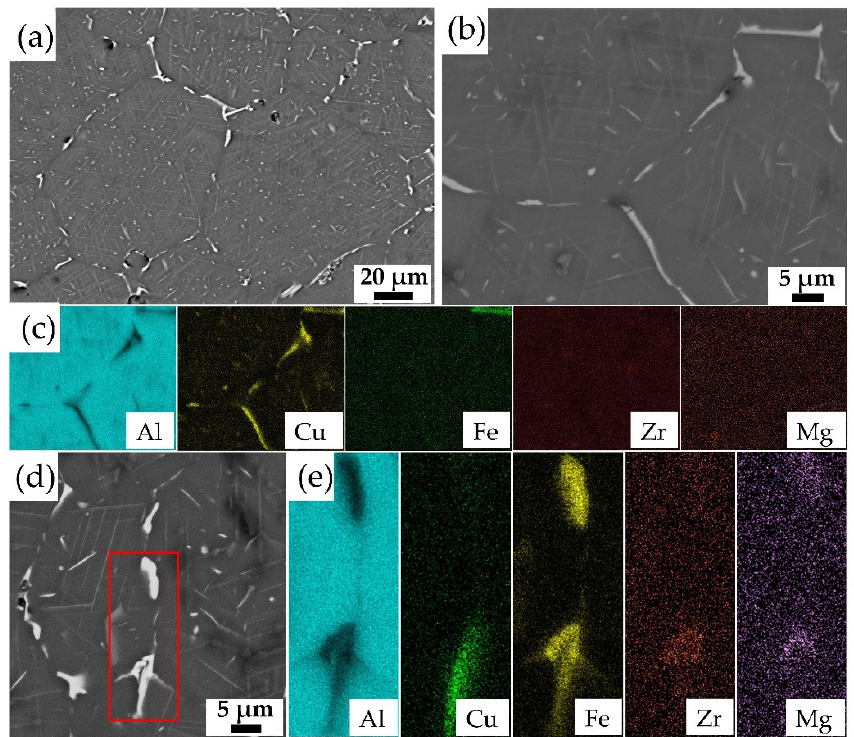
Figure 2. ( a ) Low magnification, ( b ) and ( d ) high magnification SEM images of spray deforming cast 2195 Al alloy, ( c ) and ( e ) EDS scan composition ma,ppings of Al, Cu, Fe, Zr and Mg of ( b ) and ( d